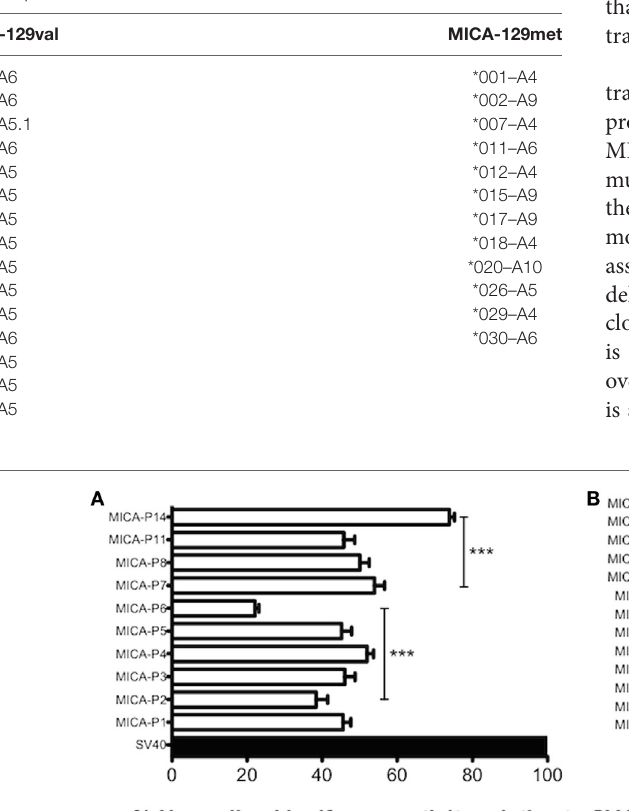
TaBle 2 | MHC class I-related chain A (MICA) alleles grouped as MICA-129val or MICA-129met and their associated transmembrane polymorphisms encoding alanine